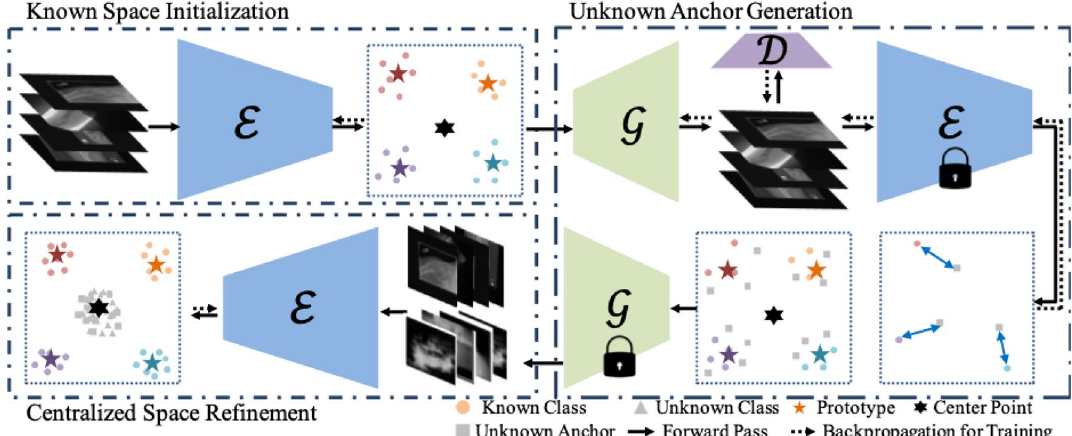
Figure 2. Framework of centralized space learning. In Known Space Initialization , E is trained to embed all known samples away from the center. In Unknown Anchor Generation , G and D are trained to generate proxy images. Then, G is fixed and used to generate proxy images. In Centralized Space Refinement , E is finetuned with proxy images and known samples to refine the centralized